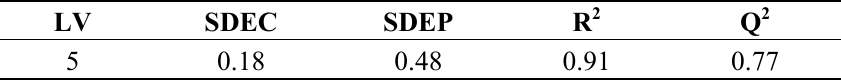
Table 7. Statistical parameters of PLS